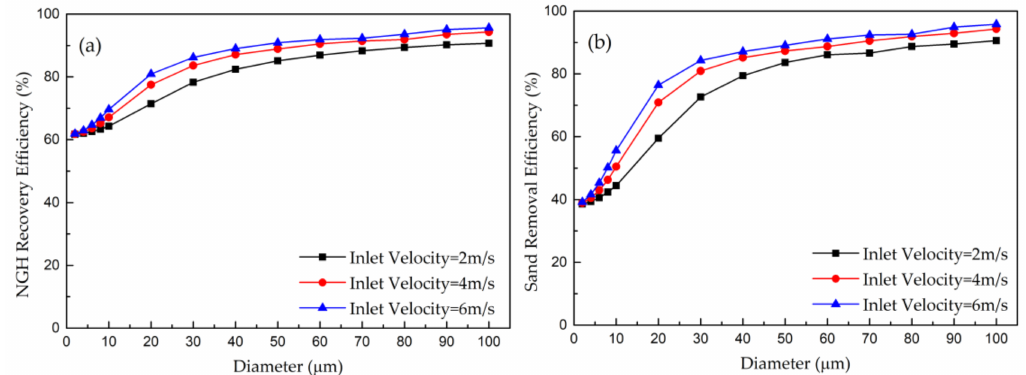
Figure 13. The relationship between particle diameter and separation e ffi ciency: ( a ) is for NGH, ( b ) is for sand.